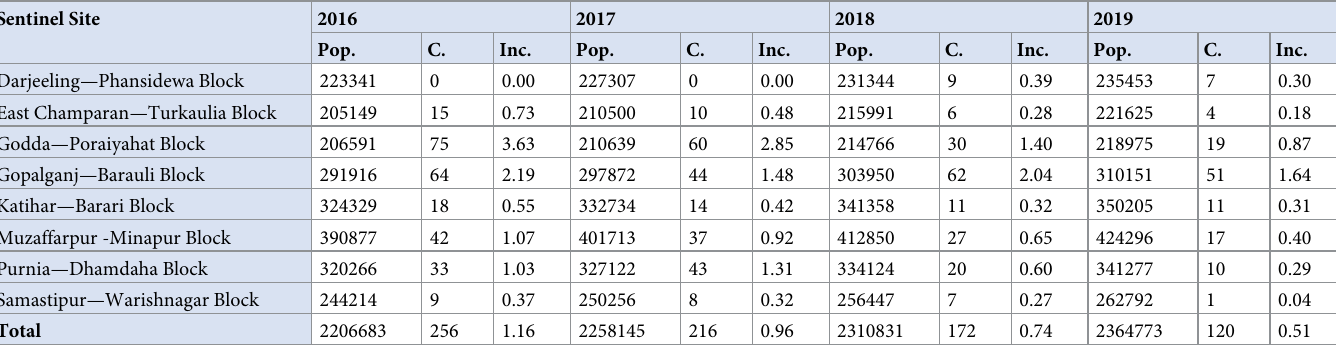
Table 4. Case data for blocks associated with sentinel sites from KAMIS. Sentinel